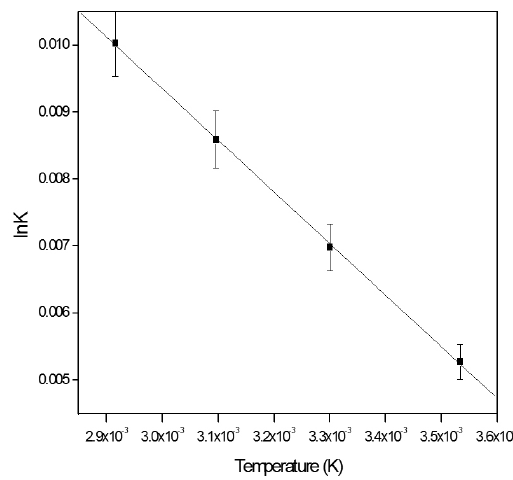
Figure 7. Arrhenius plots for the production of hydrogen gas: Dimensional of graphite rod: 80 × 20mm; Pressure: 1 atm; Electrolyte: KOH; Electrolyte concentration: 0.03 M; Applied voltage: 12 V; Applied Current: 1.2 A; Distance between the electrodes: 2 cm.